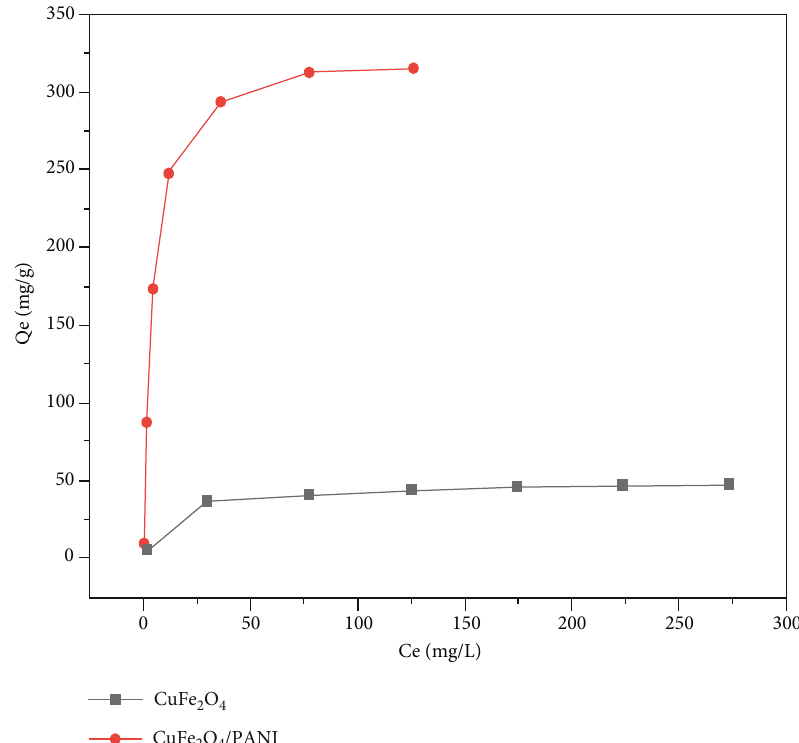
Figure 8: E ff ect of initial concentration value of solution on the adsorption of UO 22+ by CuFe nanocomposite.